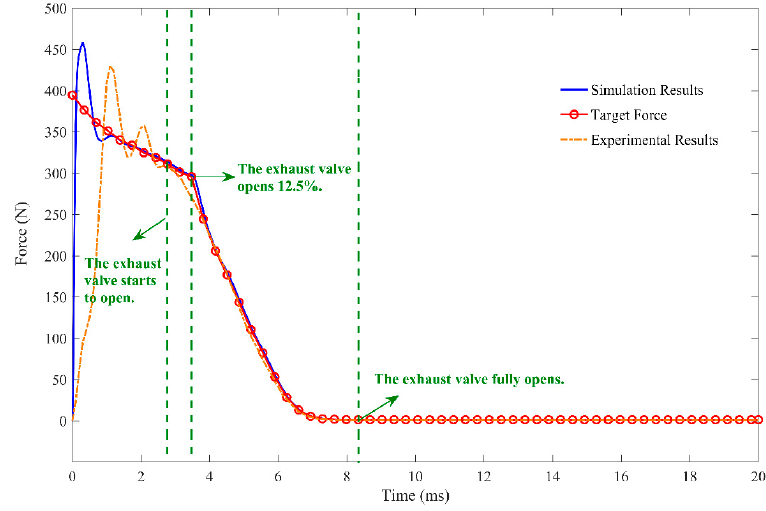
Figure 13. Comparison chart of the output force.